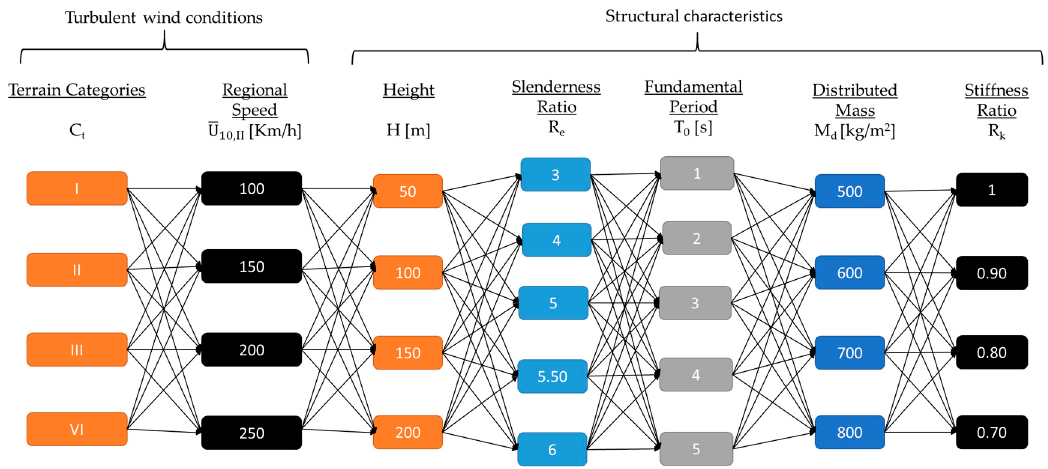
Figure 5. Parameters for definition of the structures and dynamic wind loads.